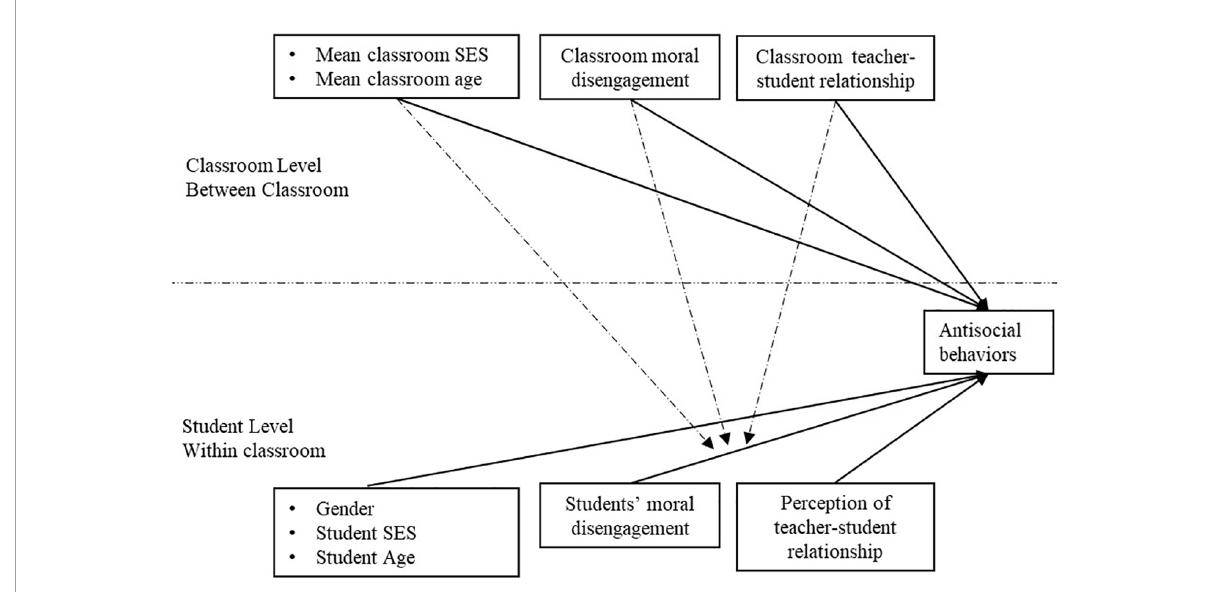
FIGURE1 Hypothesized cross-level interaction between moral disengagement within and compositional classroom predictors on antisocial